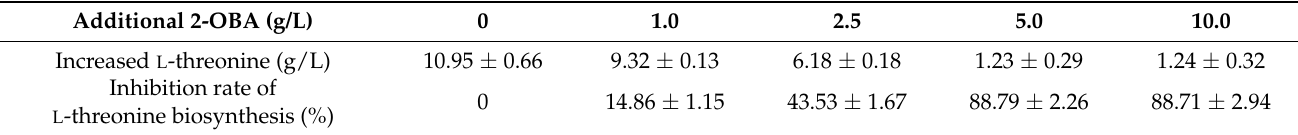
Table 1. L -threonine biosynthesis of the L -threonine producer TWF105 with the addition of various amounts of 2-OBA. Additional 2-OBA